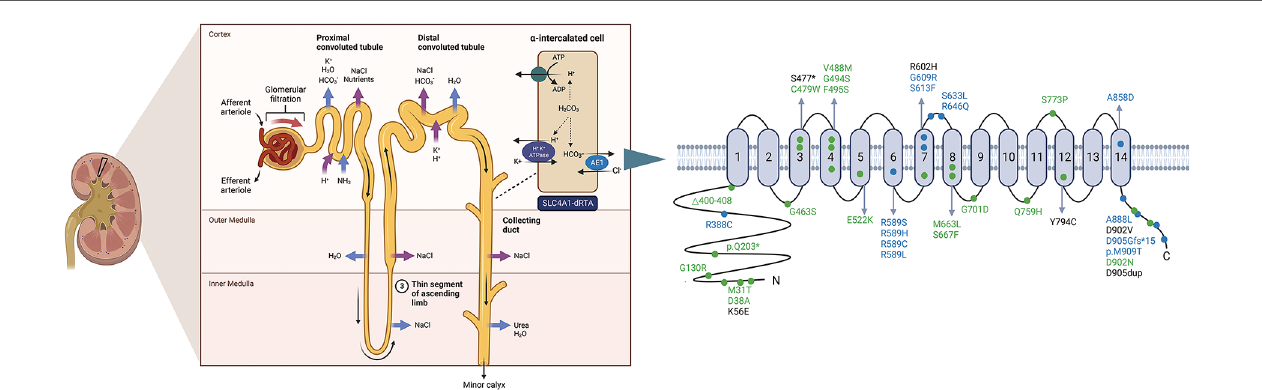
FIGURE 3 Ae1 protein and the location of the variants. Blue and green dots indicate dominant and recessive mutations, respectively. Black dots indicate the heredity is unknown. Created with